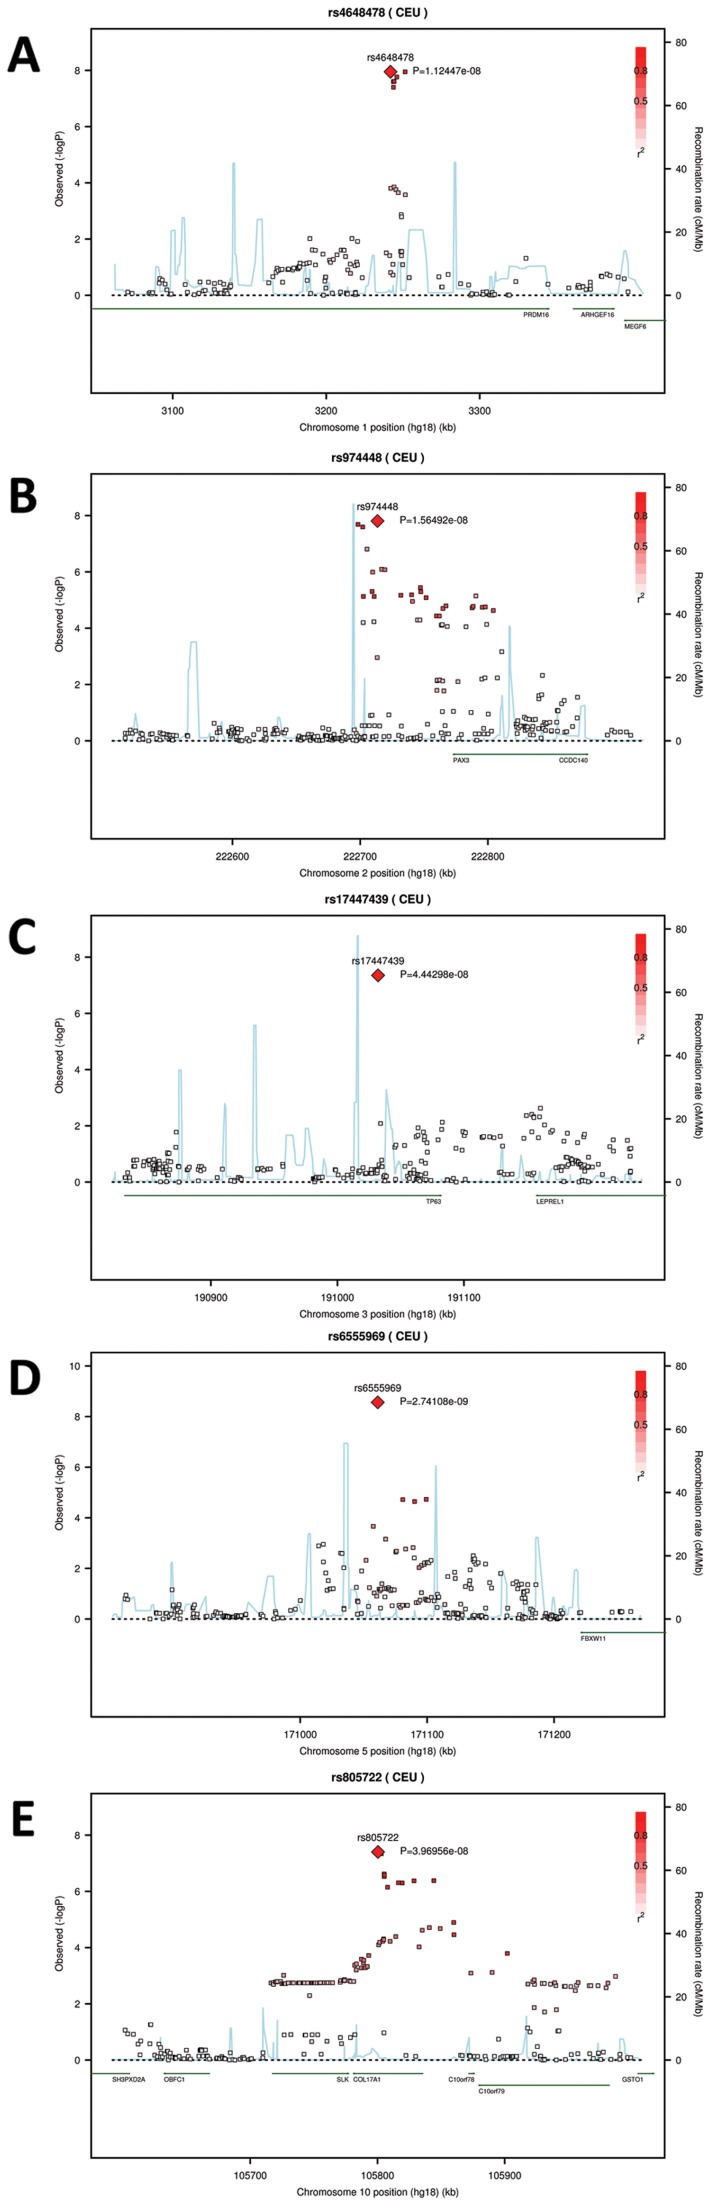
Five genomic regions harboring SNPs reaching genome-wide significant associations with facial shape phenotypes in a meta-analysis of five GWAS in discovery cohorts.The association signals (the −log10 P-values) are plotted against physical positions of each SNP in a 400 kb region centered by the most significantly associated SNP (NCBI build 36.3). Known genes in the region are aligned at the bottom. A. 1p36.23-p33 associated with AlrL-Prn, candidate gene PRDM16; B. 2q35 associated with EyeR-Nsn, candidate gene PAX3; C. 3q28 associated with EyeR-EyeL, candidate gene TP63. D. 5q35.1 associated with EyeL-Nsn, candidate gene C5orf50; E. 10q24.associated with EyeL-Nsn, candidate gene COL17A1.